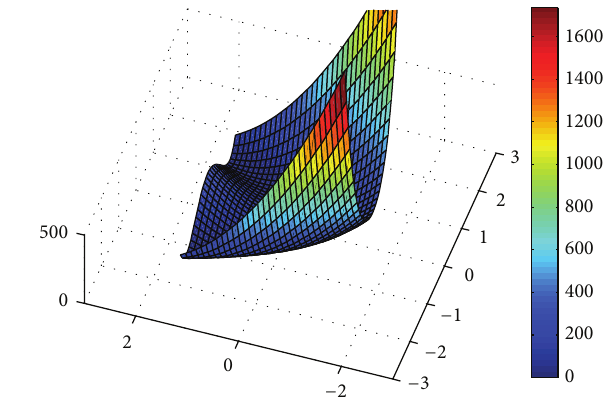
Figure 1: The solution space of the Rosenbrock function.